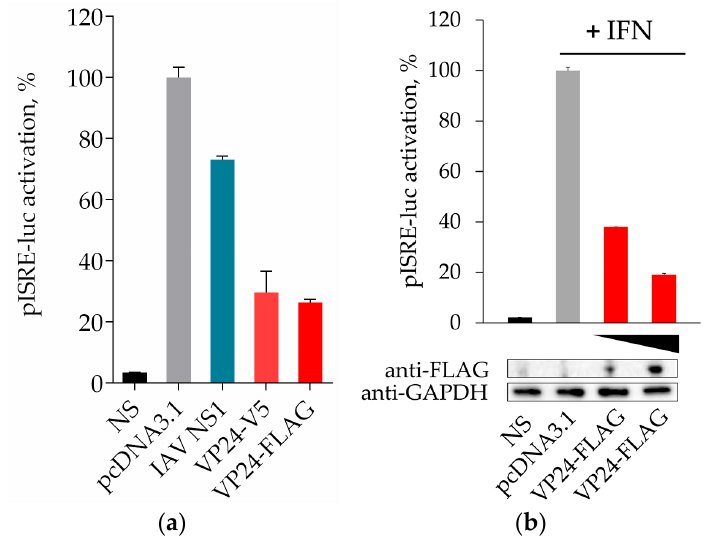
Figure 2. Ebola virus (EBOV) VP24 inhibition assay. ( a ) HEK293T cells were transfected with pISRE-luc and 60 ng/well of empty vector pcDNA3.1(+), or expression plasmid for EBOV FLAG- or V5-tagged VP24 and IAV NS1. Twenty-four hours after transfection, cells were stimulated with 10 ng/mL of IFN- α or left untreated (NS). After 8 h, cells were lysed and luciferase activity was measured. ( b ) Expression of EBOV VP24 at protein level. HEK293T were seeded in a 6-well plate. After 24 h, cells were transfected with pISRE-luc and pcDNA3.1 (1 µ g/well) and 0.25 and 1 µ g/well of EBOV VP24-FLAG. The day after, cells were incubated or not with IFN- α for 8 h and subsequently lysed and examined for luciferase activity and protein expression by Western blotting. Results are shown as percentage of pISRE-luc activation in VP24 transfected cells over empty vector transfected controls. Each experiment was done in triplicate. Error bars indicate the mean ± SD.